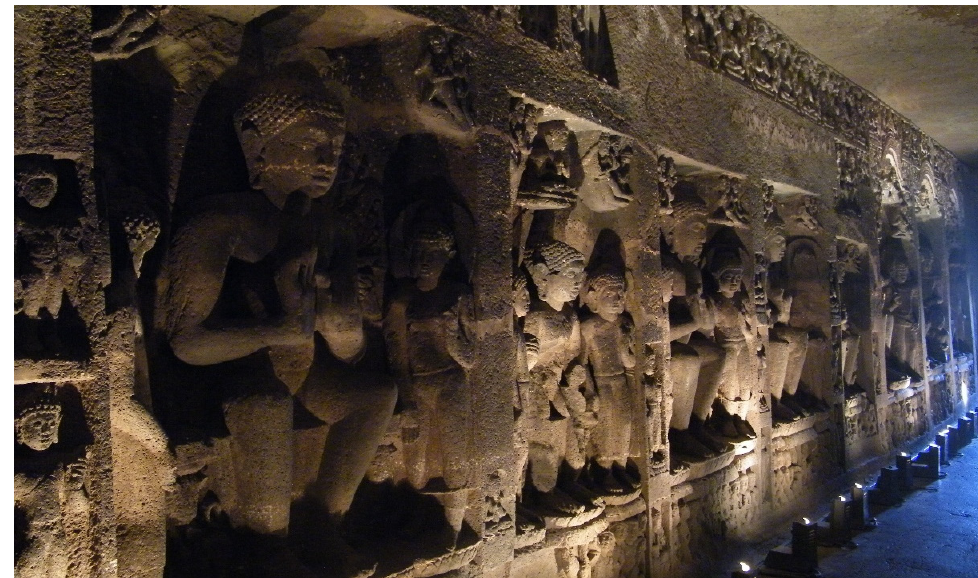
Figure 11. Intrusive panels from Aja ṇṭ ā Cave 26, circumambulatory wall, ca. 478–480 CE (Photograph by the author).